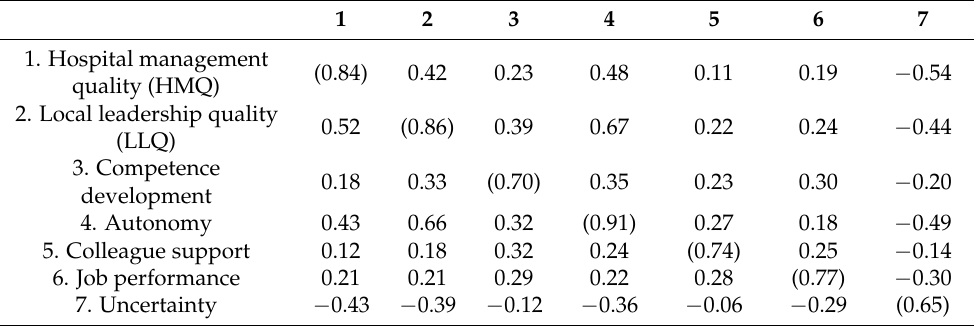
Table 3. Cronbach’s alpha (total sample in parentheses) and correlations among nurses (below diagonal) and physicians (above